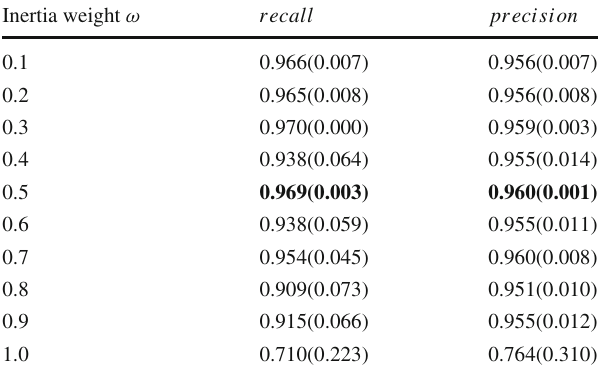
Table 6 Experimental results on the sensitivity of inertia weights ω Inertia weight ω